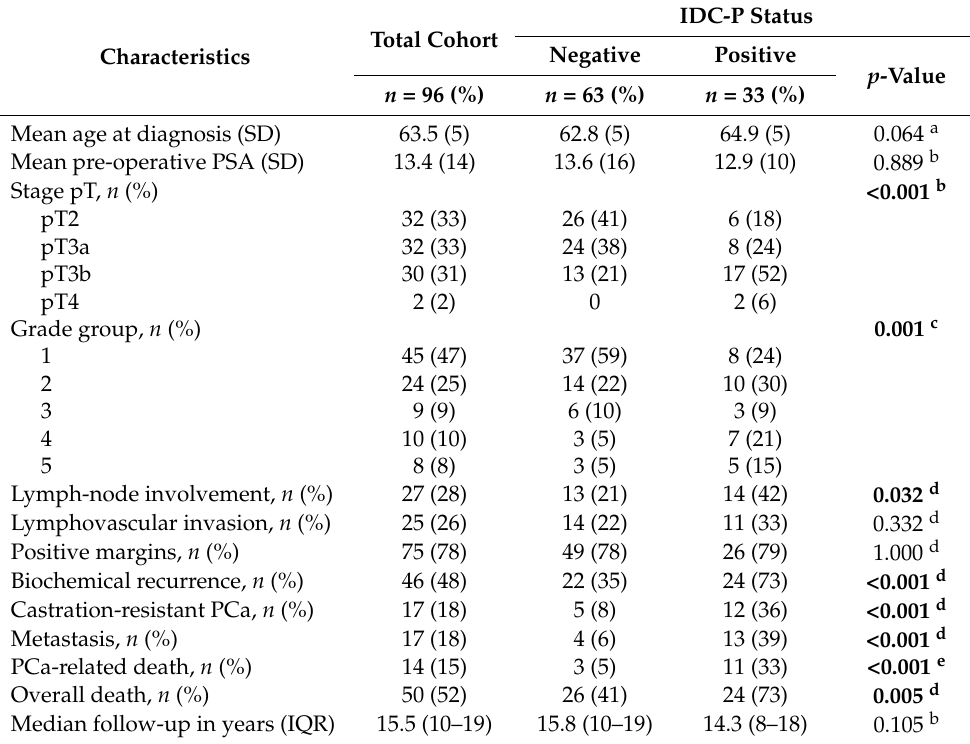
Table 2. Clinicopathological characteristics of patients according to the presence or absence of intraductal carcinoma of the prostate (IDC-P) on representative